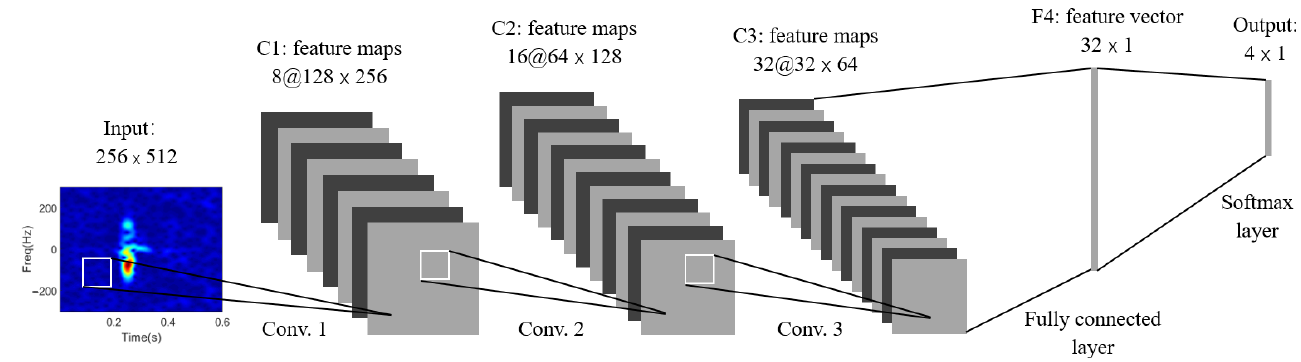
Figure 13. CNN architecture of three convolutional layers.